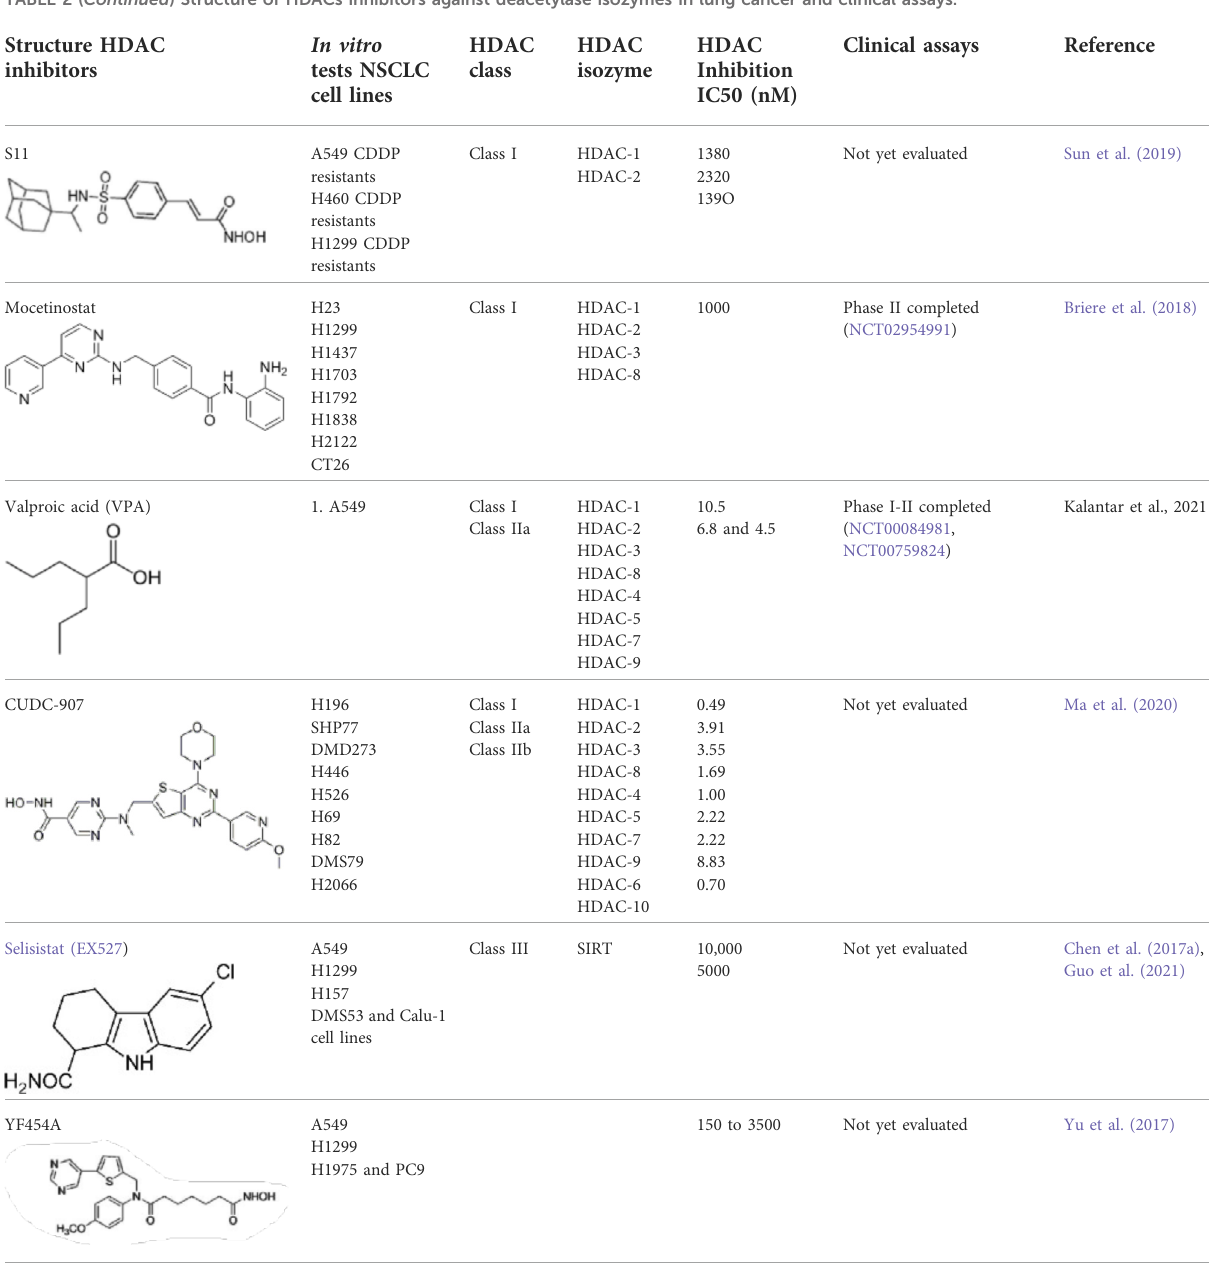
TABLE 2 ( Continued ) Structure of HDACs inhibitors against deacetylase isozymes in lung cancer and clinical